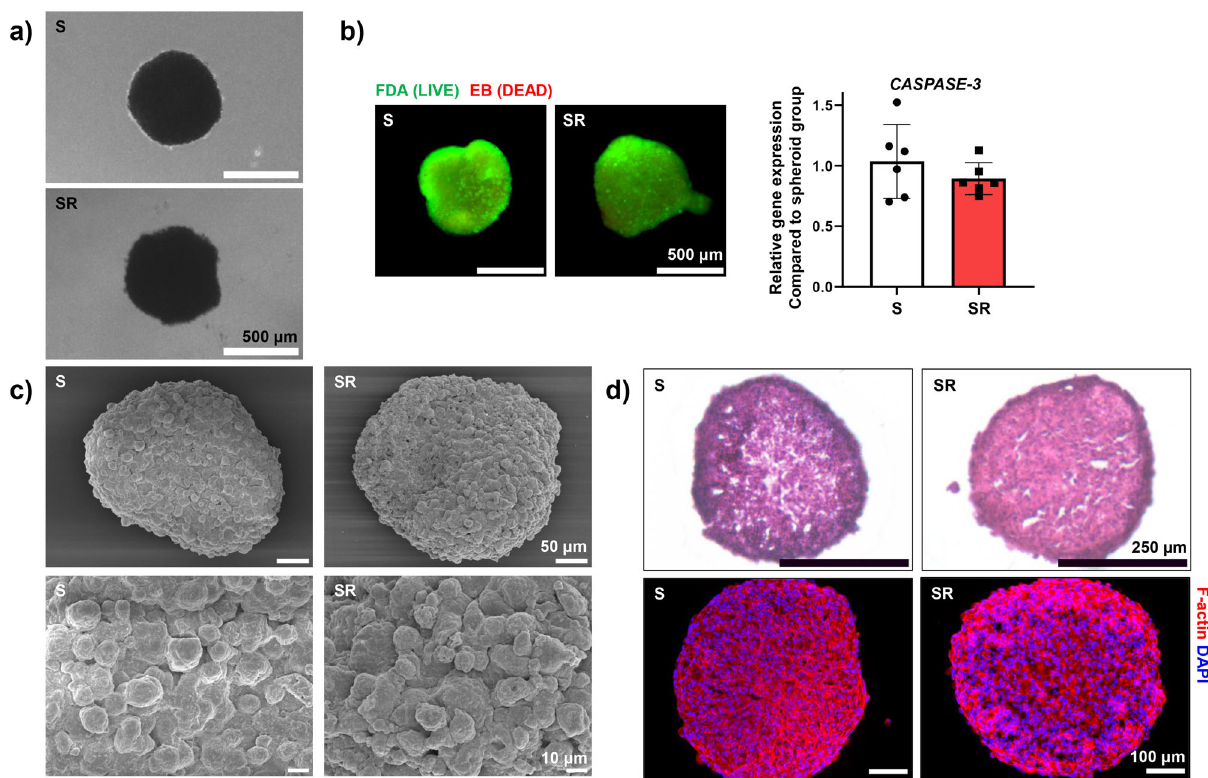
Fig. 3 Spheroid morphology, and viability of spheroid hADSCs cells following red light stimulation. a Representative morphology of hADSCs spheroid following red light treatment. b Cellular viability of the hADSC spheroids following red light treatment, evaluated using the fl uorescein diacetate ethidium bromide (FDA-EB) assay (green, live cells; red, dead cells; scale bars, 500 μ m) and expression of CASPASE-3 in hADSC spheroids ( n = 6, Data are presented as mean ± S.D.). c Representative SEM image of fabricated spheroids. d H&E and F-actin staining in the interior of spheroids (S and